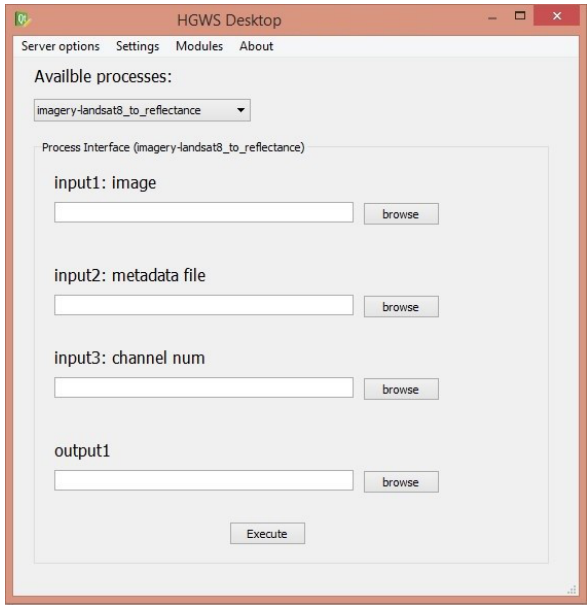
Figure 8. Graphical UI of the HGWS client RE for